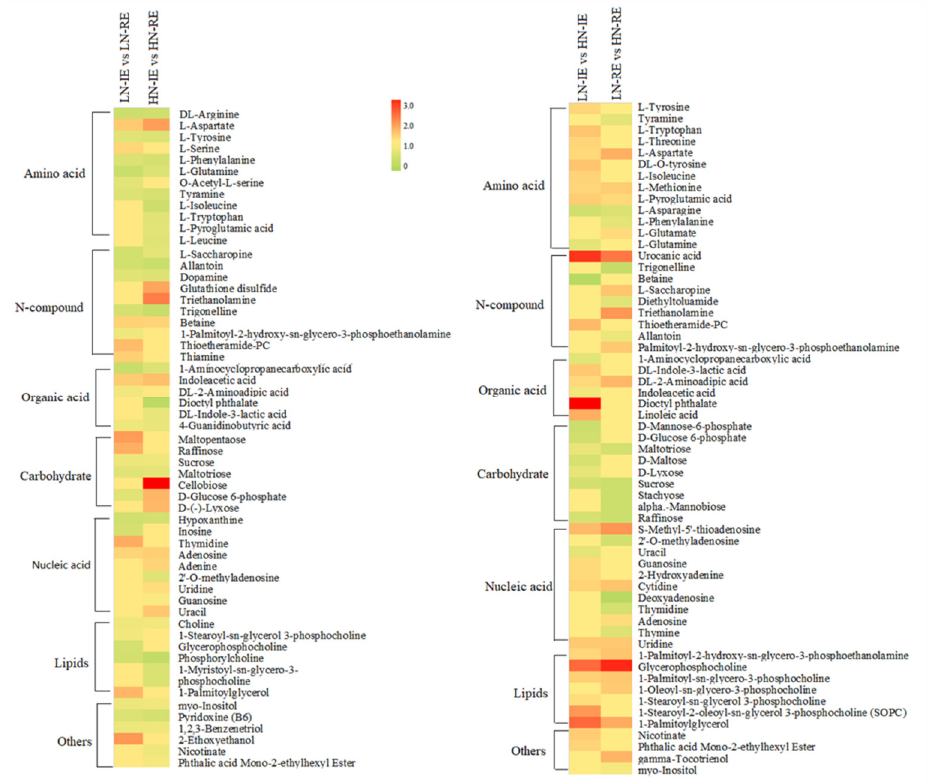
Figure 5. Heat map of di ff erentially expressed metabolites in two parts of endosperm region under high and low nitrogen treatment. HN-IE and HN-RE are samples from innermost endosperm region and the remaining endosperm region under high nitrogen treatment, respectively. LN-IE and LN-RE are samples from innermost endosperm region and the remaining endosperm region under low nitrogen treatment, respectively. Heat map represent the ration of relative abundance of LN-IE vs LN-RE, HN-IE vs HN-RE, LN-IE vs HN-IE, and LN-RE vs HN-RE.